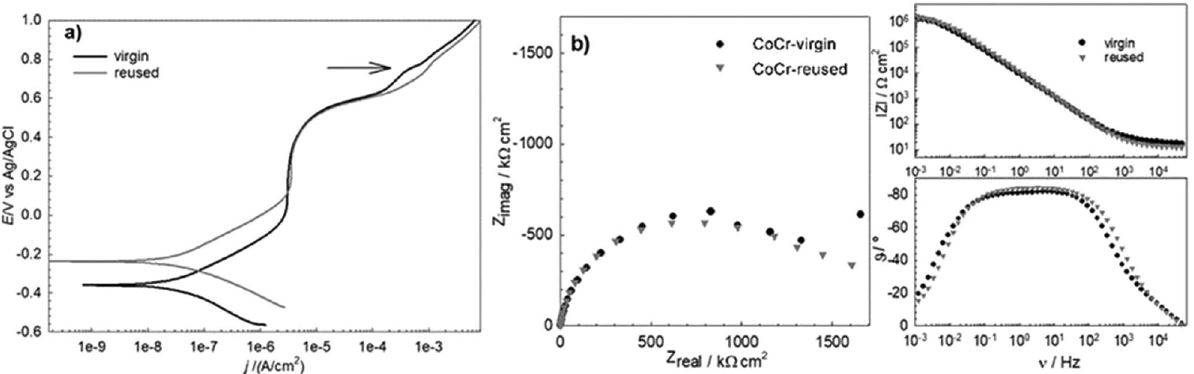
Figure 10. Potentiodynamic polarization curves ( a ) and Nyquist and Bode plots ( b ) for the CoCr alloys 3D printed from virgin and reused powder in artificial saliva with NaF.